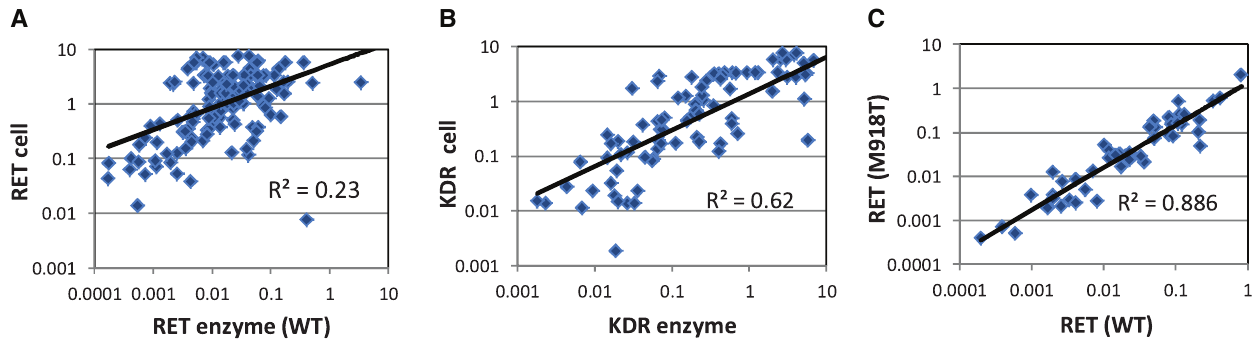
Figure 2. Correlation of IC data: A ) RET enzyme vs RET cellular POM B ) KDR enzyme vs KDR cellular POM C ) RET enzyme WT vs RET 50 (M918T). All data points represent the geometric mean of at least two independent measurements.